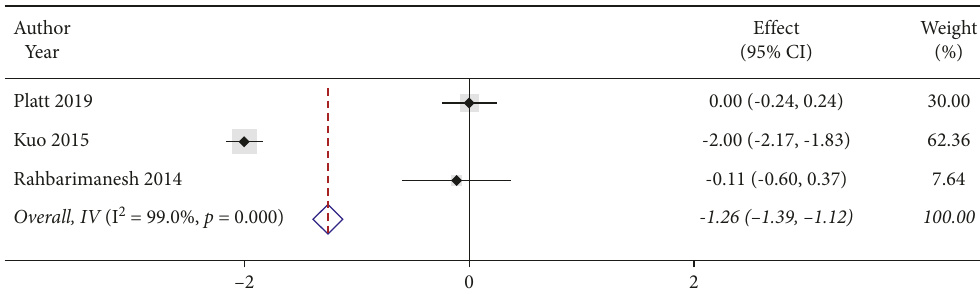
Figure 6: The relative risk of the length of hospitalized days identified in the meta-analysis from three enrolled